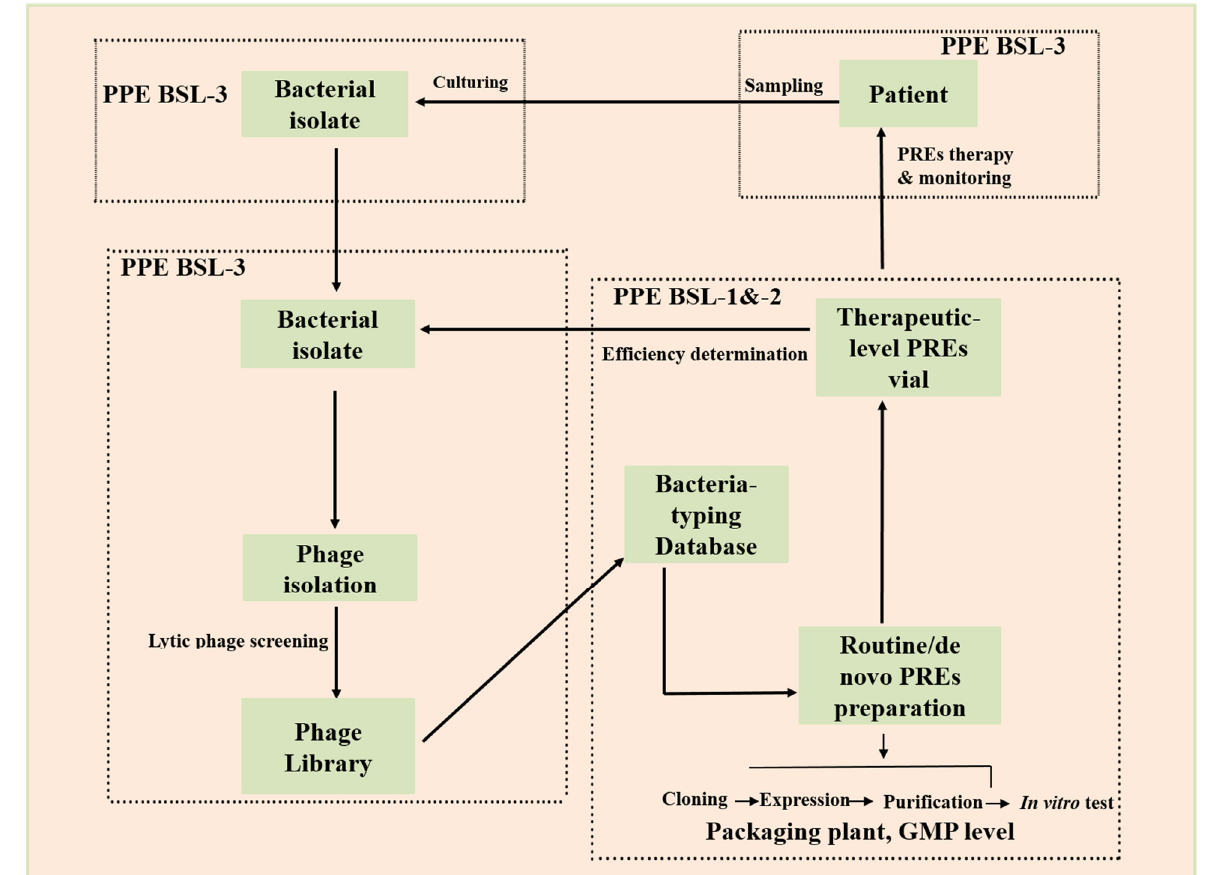
Figure 3. Workflow for COVID-19 infection management proposed in this study [76]. With an established phage library, against a given pathogenic bacterium that has been isolated from a patient or a hospital surface are screened, and pre-stocked phage-enzymes vials are delivered for application to the patient or the environment. PREs: phage-related enzymes.